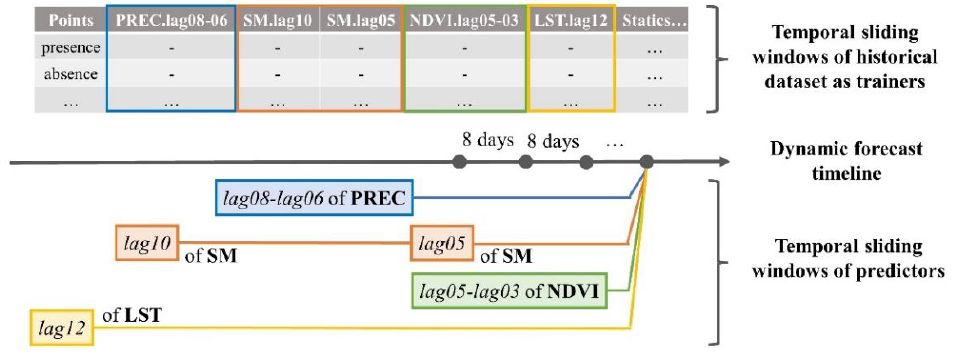
Figure 3. Illustration of time lag sliding window technique.